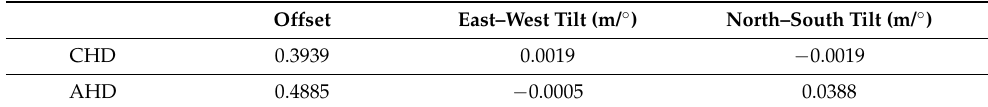
Table 7. The parameter results of the parametric model were calculated using vertical offsets of the Chinese height datum (CHD) and the Australian height datum (AHD) (unit: m).